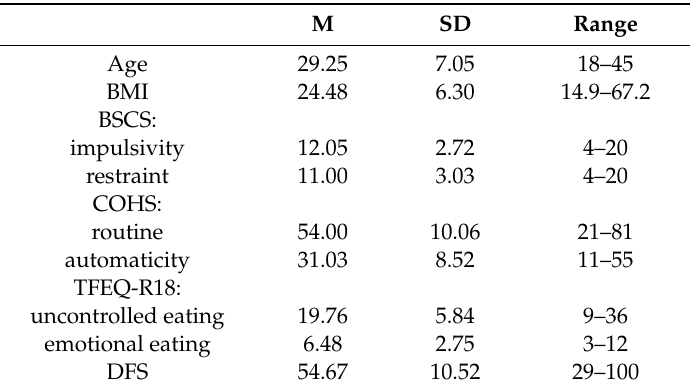
Table 1. Demographics and